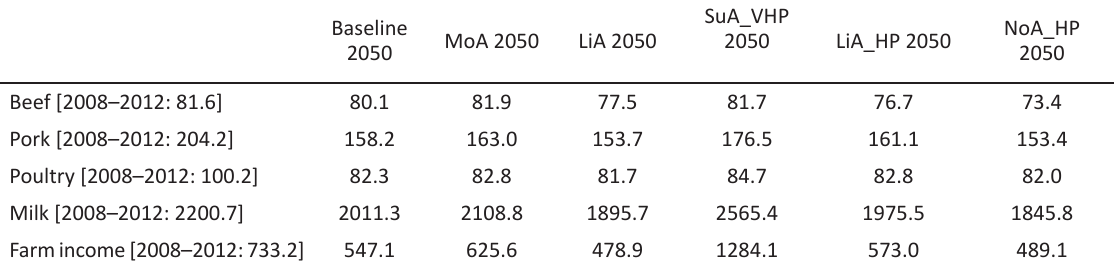
Table 3. Simulated livestock production (meat in 1000s tons, milk in mill. litres) and farm income (eur mill.) in 2050 [Observed average values for 2008–2012 are given for comparison]